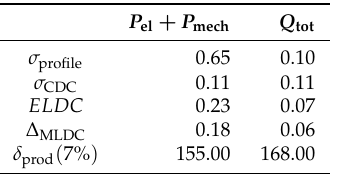
Table 3. Performance parameters for the 5-cluster power and heat.